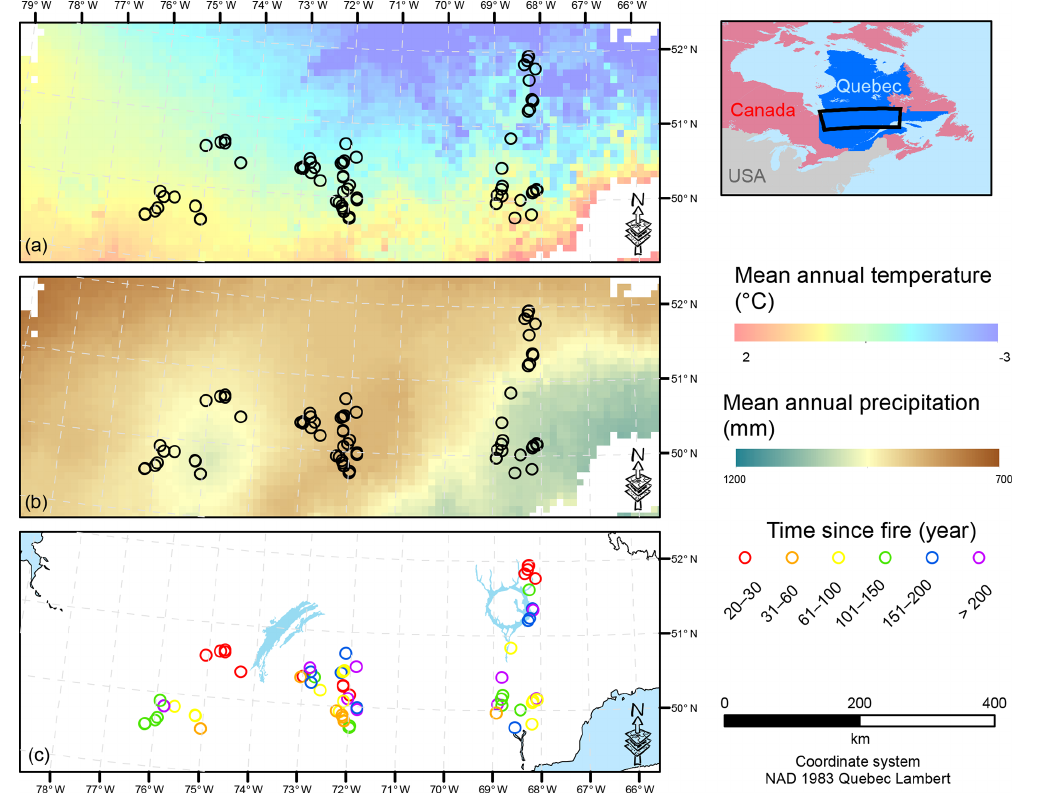
Figure 1. Map of the study area showing the location of the sample plots. Mean annual temperature (a) and mean annual precipitation (b) are interpolations from the 1981–2010 Canadian climate normals on a 10 × 10km pixel grid (Chaste et al., 2018). The lower panel presents the location of the sample plots in relation to the time since fire (year). NAD: North American